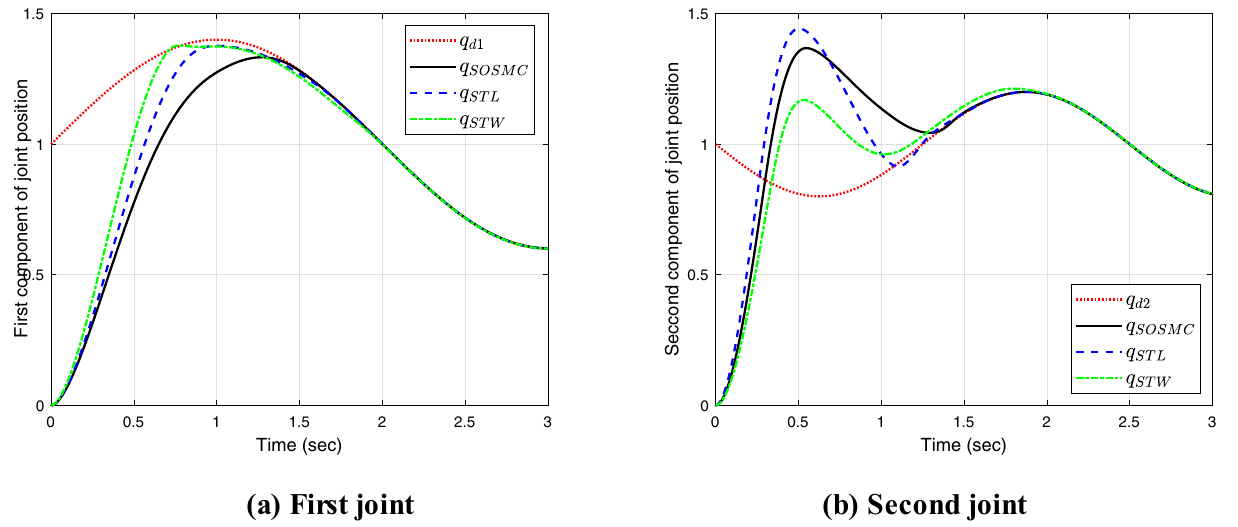
Fig. 8 Comparison of positions q 1 and q 2 of first and second joints for SOSMC, STW and STL